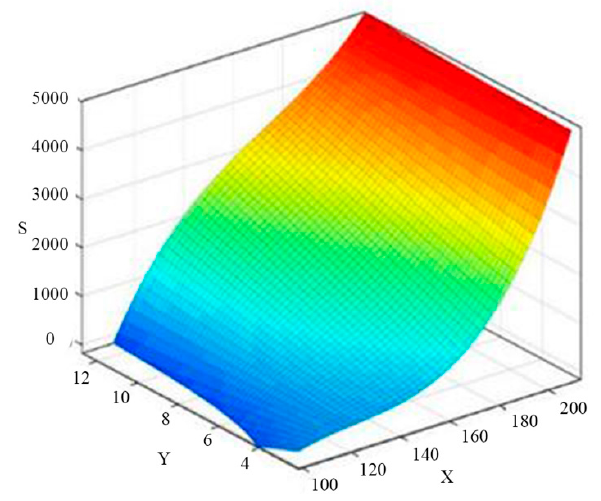
Figure 12. Three-dimensional space model of factors (X, Y) and responses (S).